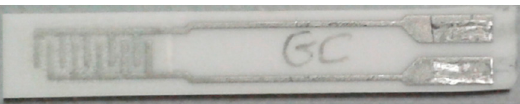
Figure 3. Screen-printed glass ceramic (GC) film onto alumina substrate with Pt interdigitated electrodes.